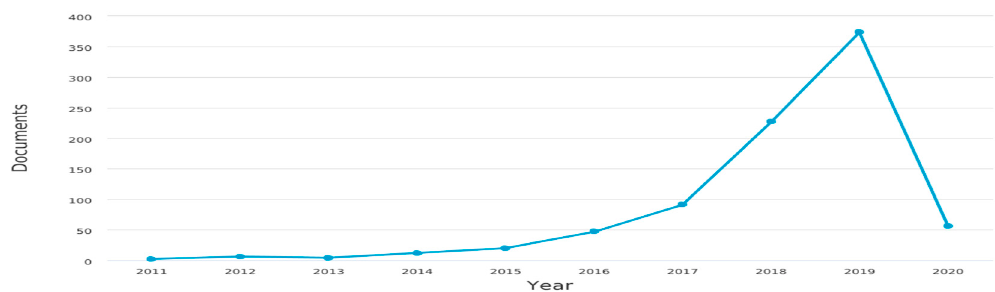
Figure 3. Sharp rise in the use of AI techniques for cognitive sensing solutions in recent years .